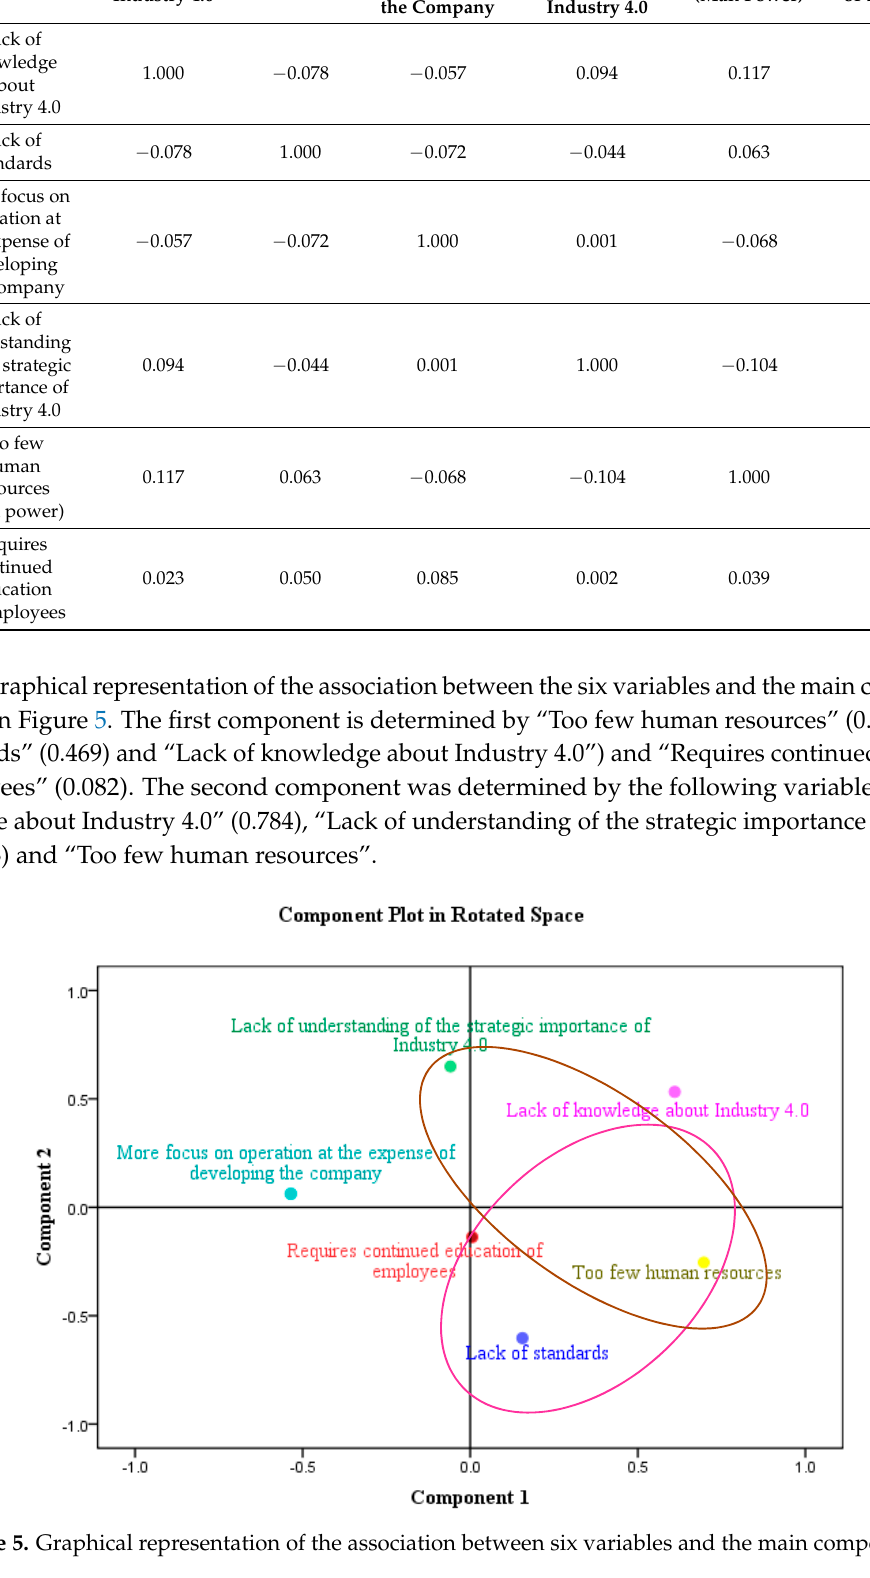
Figure 6. SME representation by industry in terms of the two main components.